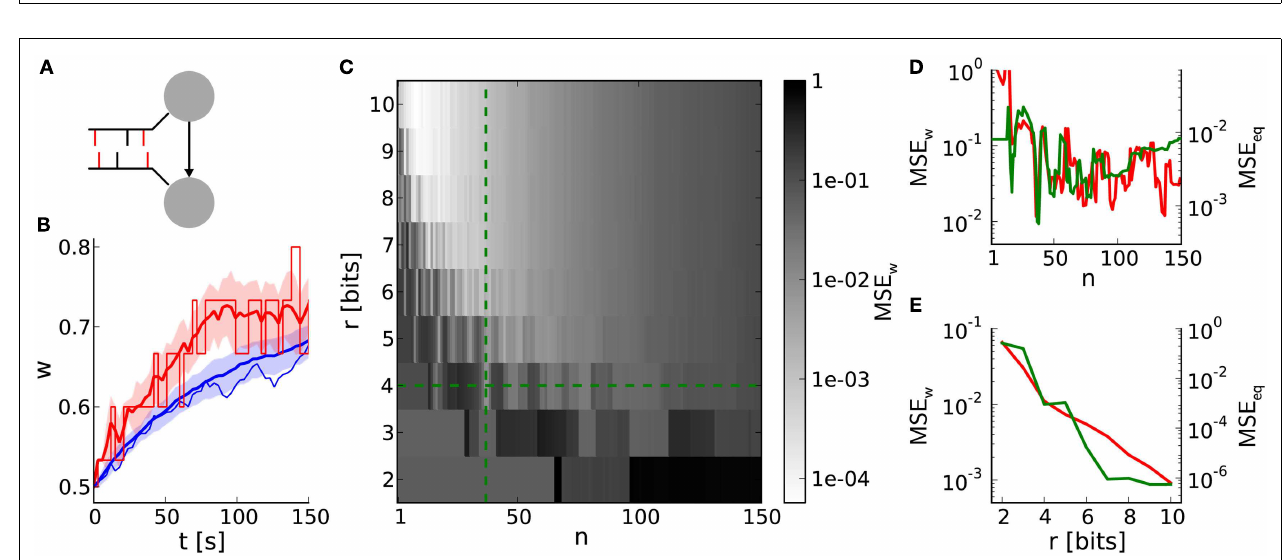
FIGURE 5 | Software implementation of STDP on discrete weights in spiking neural networks. (A) Temporal evolution of spike pair accumulations a (dimensionless) for causal (black) and anti-causal (gray) spike-timing-dependences. If a crosses the threshold a th (cyan), the weight is updated and a is reset to zero. Pre- and postsynaptic spike trains are generated by a MIP with c = 0.5 and r = 10Hz. (B) Corresponding weight